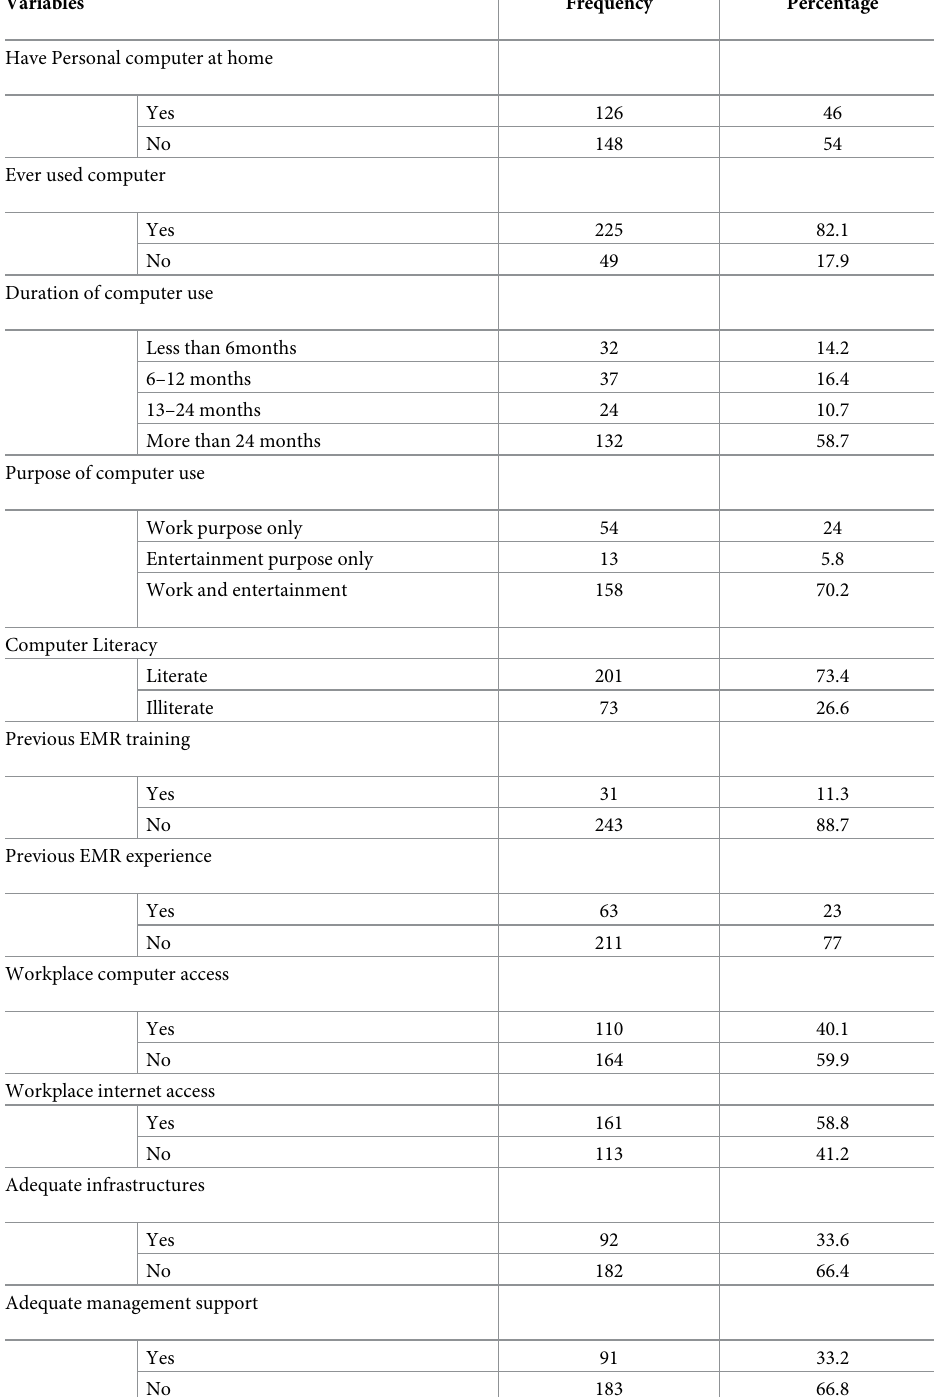
Table 2. Technical and organizational factors for health professional readiness in Sidama